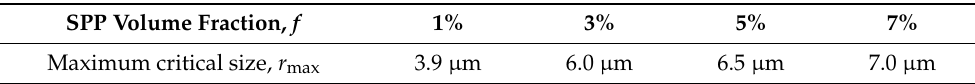
Table 3. Comparison of critical sizes for different SPP volume factions.